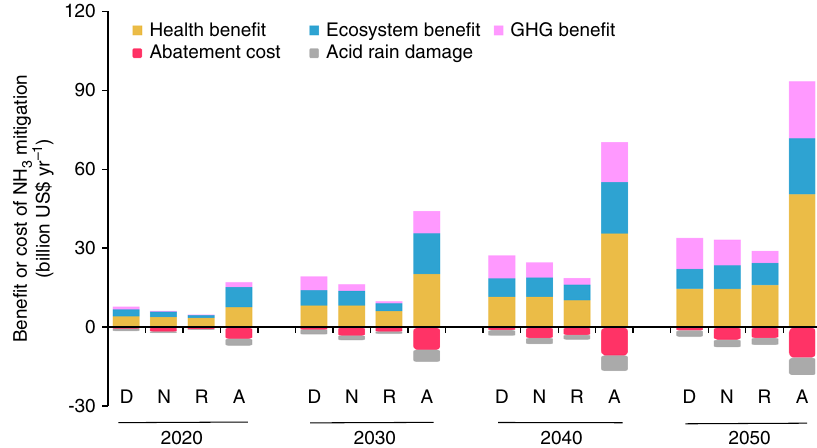
Fig. 3 Costs and bene fi ts of NH3 mitigation during 2020 – 2050 in China. D, N, R, A refer to the DIET, NUE, REC and ALL scenarios, respectively; each scenario features different mitigation pathways and generates different mitigation costs and bene fi ts. Source data are provided as a Source Data fi